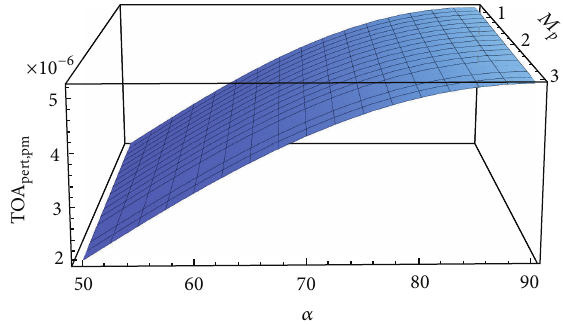
Figure 3: Values of TOA range of values of the planet mass 𝑀 𝑝 and moon orbit inclination 𝛼 . We have also chosen sin 𝐼 = 1 , 𝑅 = 23 AU, 𝑟 = 𝑅/40 , and 𝑀 /10 𝑀 𝑝